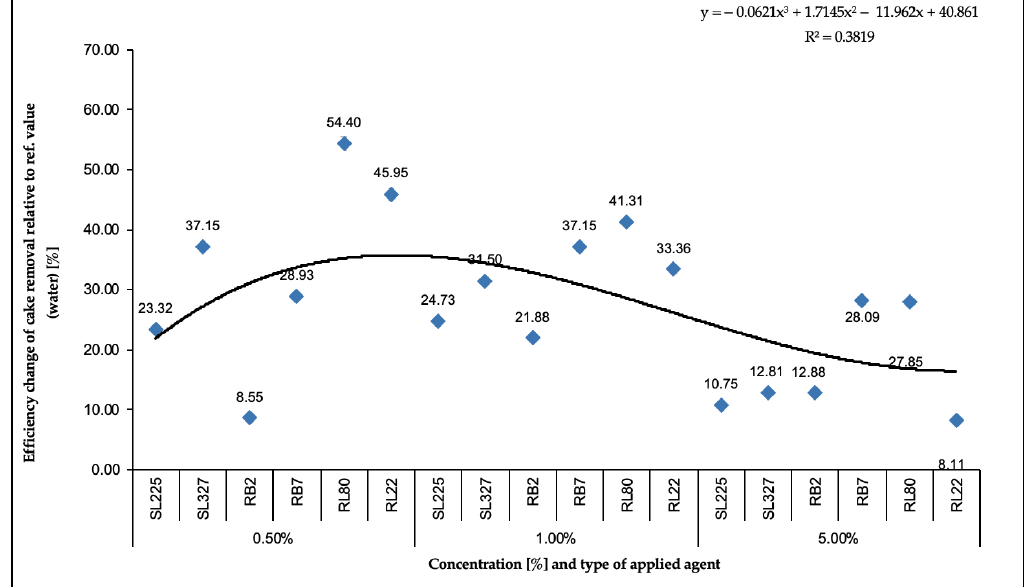
Figure 10. Efficiency change of cake removal with new agents, depending on the applied concentration. Water was used as a reference value.